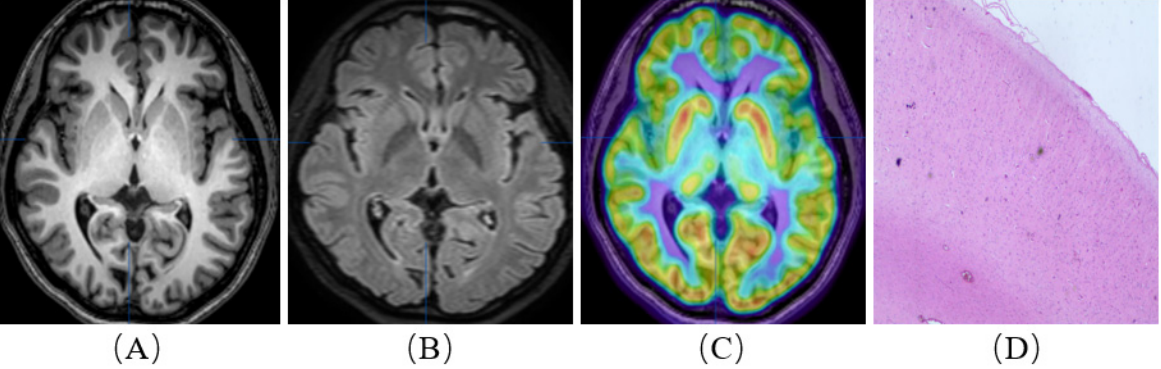
Figure 1. A patient with refractory epilepsy to drug therapy. She was born in 1993 and was admitted when she was 26 years old. Her first seizure occurred at 16 years old. Neither MRI nor (18F)-FDG PET/MRI ( A – C ) showed the epileptic focus. Resective surgery was planned for the patient, and an intracranial electrode was used. The intracranial electrode indicated the right frontal lobe region. Postoperative histopathological examination confirmed ‘type I b, focal cortical dysplasia’ ( D ). The patient is currently seizure-free (Engel III–IV).